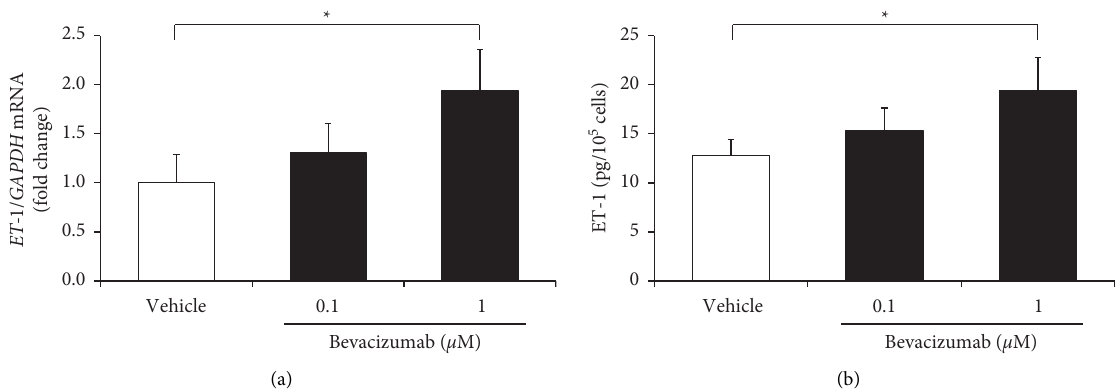
Figure 1: Bevacizumab induced ET-1 production in cultured human glomerular microvascular endothelial cells (hGECs). hGECs were plated in 24-well plates (1 × 10 5 cells/well) for ELISA or 60 mm culture dishes (1 × 10 6 cells/dish) for RT-PCR. hGECs that were 90% confluent were serum-starved for 24h before the experiments were performed. hGECs were treated with 0.1 or 1 µ M bevacizumab for 8h, RNA was extracted from the cells, and ET-1 mRNA level was examined by real-time RT-PCR (a). The medium was collected and ET-1 protein level was examined by the ELISA (b). Data shown are means ± SD ( n � 3; ∗ p < 0.05). The experiments were repeated at least three times, with reproducible